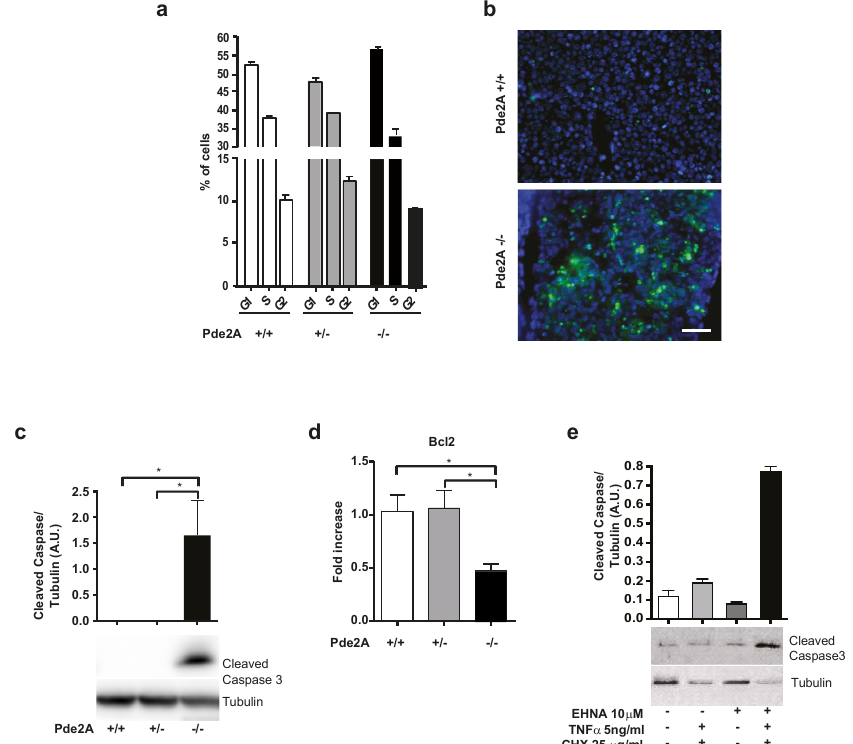
Figure 3. Apoptosis is increased in liver of PDE2A − / − embryos. ( a ) Cells dissociated from liver of E14.5 PDE2A + / + , PDE2A +/ − and PDE2A − / − embryos display cell cycle similarities by flow cytometry analysis. (b ) TUNEL staining shows increased apoptosis in livers sections derived from E14.5 PDE2A − / − embryos respect to PDE2A +/+ embryos. Scale bar: 50 µ m. N = 3 embryos / genotype. ( c ) Representative western blot analysis of cleaved caspase-3 expression in liver extracts of E14.5 PDE2A +/+ , PDE2A +/ − and PDE2A − / − embryos. Densitometry is shown relative to tubulin expression. N=3 embryos/genotype. ( d) qRT-PCR in E14.5 liver embryos showing Bcl2 expression. N = 3 embryos/genotype. ( e ) E14.5 liver cells isolated from C57BL/6 embryos enter apoptosis after TNFα (5 ng/mL) and CHX (25 µg/mL) treatments if pretreated with the PDE2A inhibitor EHNA (10 µM). Apoptosis was evaluated by cleaved caspase-3 in western blots. Densitometry analysis relative to tubulin is shown. N = 2 embryos. * P < 0.05.